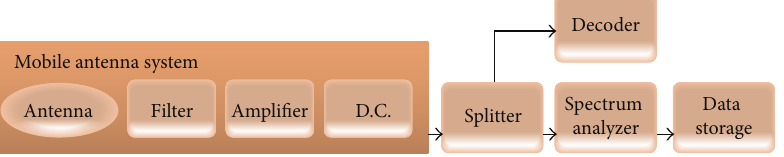
Figure 8: Measurement setup for the mobile terminals scenario.